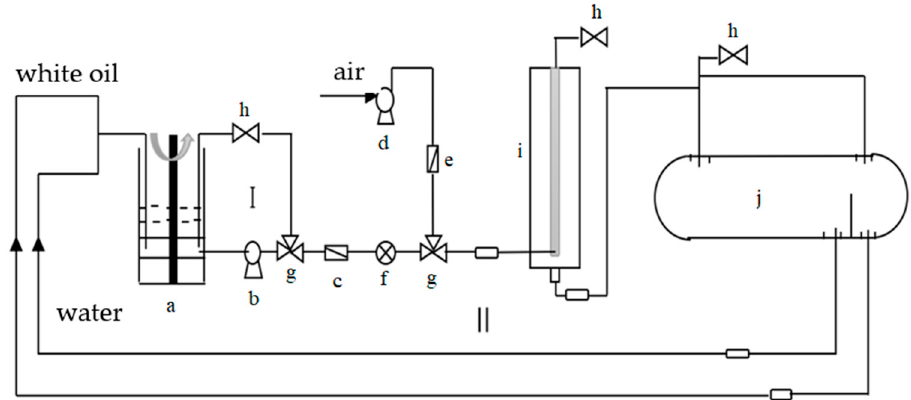
Figure 10. Flow chart of the laboratory experiment. (a) Small mixing barrel; (b) booster pump; (c) liquid flowmeter; (d) gas pump; (e) gas flowmeter; (f) check valve; (g) tee; (h) bypass valve; (i) vertical separator; and (j) horizontal separator.